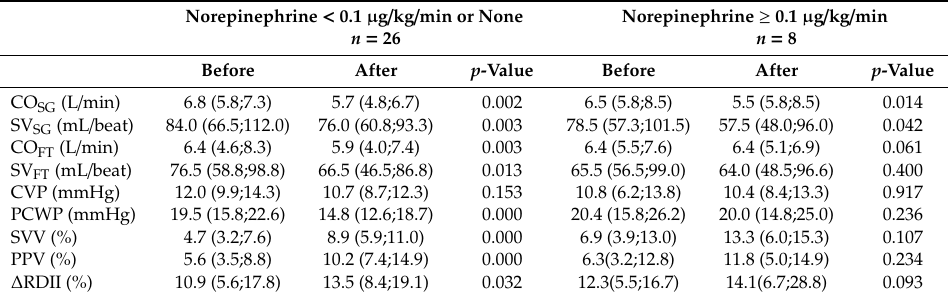
Table 3. Comparisons of ∆ RDII and other variables according to the dose of continuous norepinephrine infusion during inferior vena cava